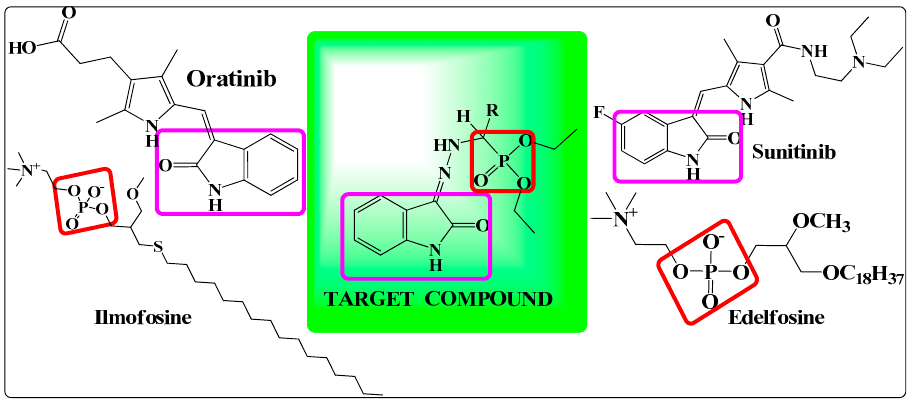
Figure 1. Designing protocol for target compounds 4 ( a – n ).